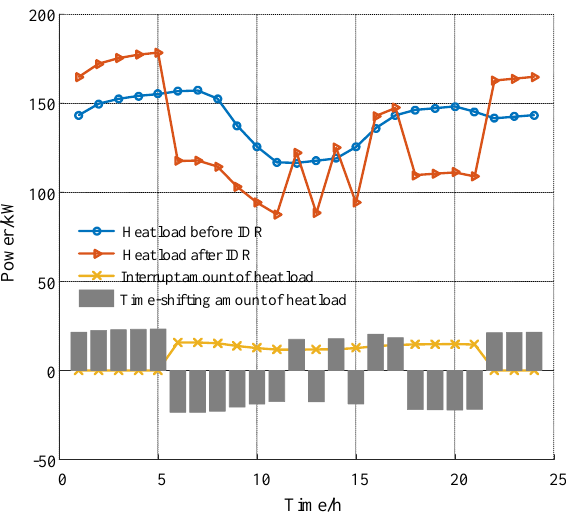
Figure 8. Comparison of the PIES thermal load operation schedule before and after IDR.